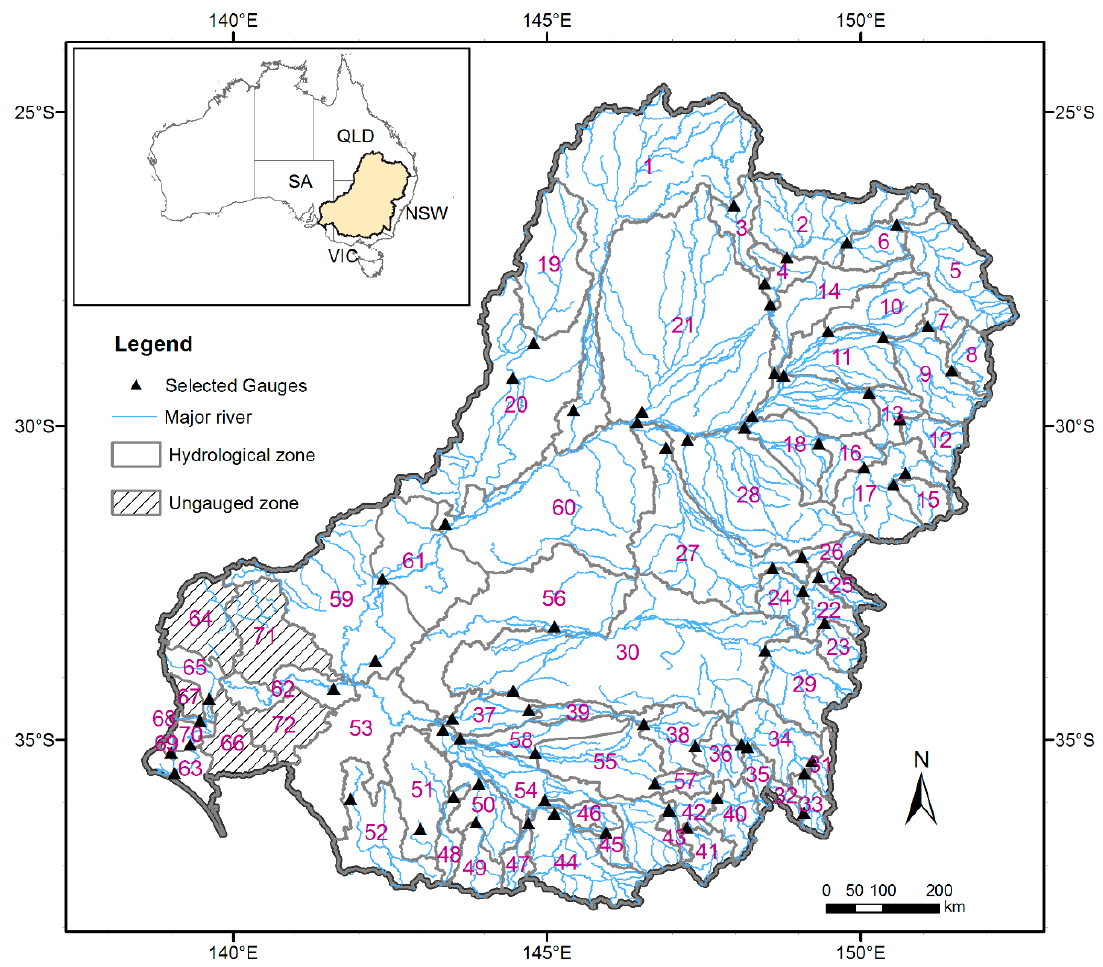
Figure 2. Hydrological zones and their corresponding gauges.